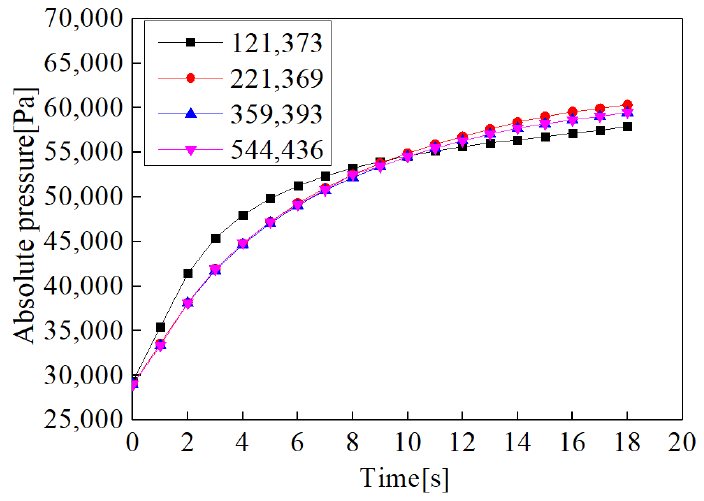
Figure 4. Comparison of absolute pressure calculated by four meshes.